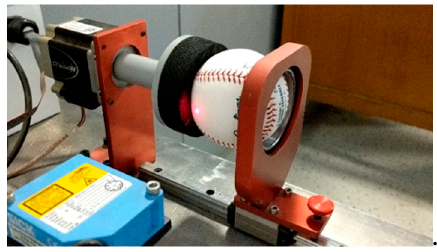
Figure 4. Laser profiler used to measure seam height of